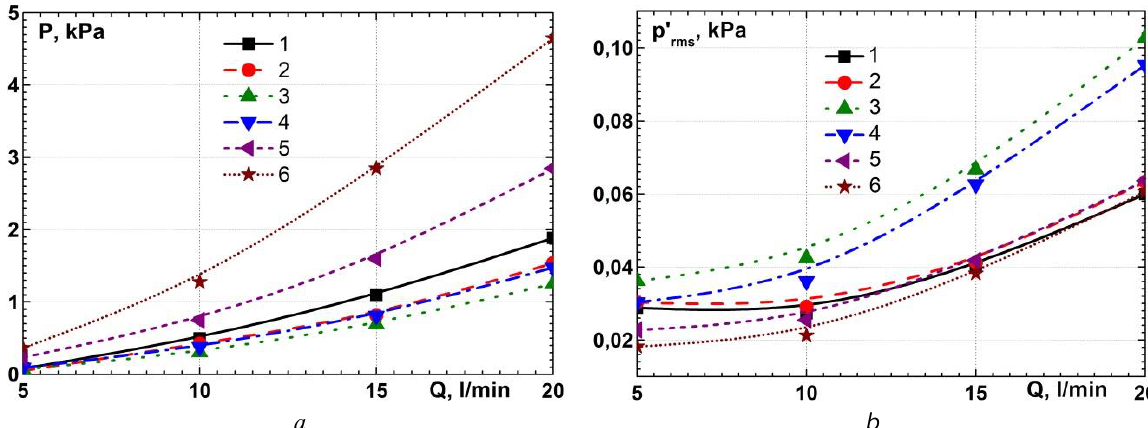
а b Figure 4. Integral characteristics of the pressure field: mean values of the pressure (a) and root mean square values of the pressure fluctuations (b) It is known [52] that the characteristic measure of the random variable (pressure fluctuations) is the probability () P p  that the random variable ( p  ) will take one value or another or falls into a given interval ( p   ). The first derivative of the distribution function of the random variable () pp  sets the velocity of change of the probability depending on the value of the pressure fluctuations. Usually, the function () pp  is estimated by calculating the probability that the instantaneous value of an individual implementation is in a narrow interval and is divided by the